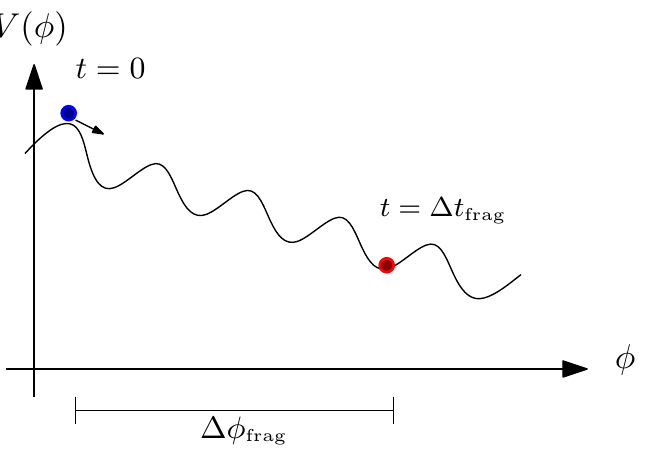
Figure 1 . Sketch of the axion potential given in eq. (2.1). Once axion fragmentation starts, the (cid:12)eld (cid:30) takes a time (cid:1) t frag and moves a distance (cid:1) (cid:30) frag until it gets trapped in one of the